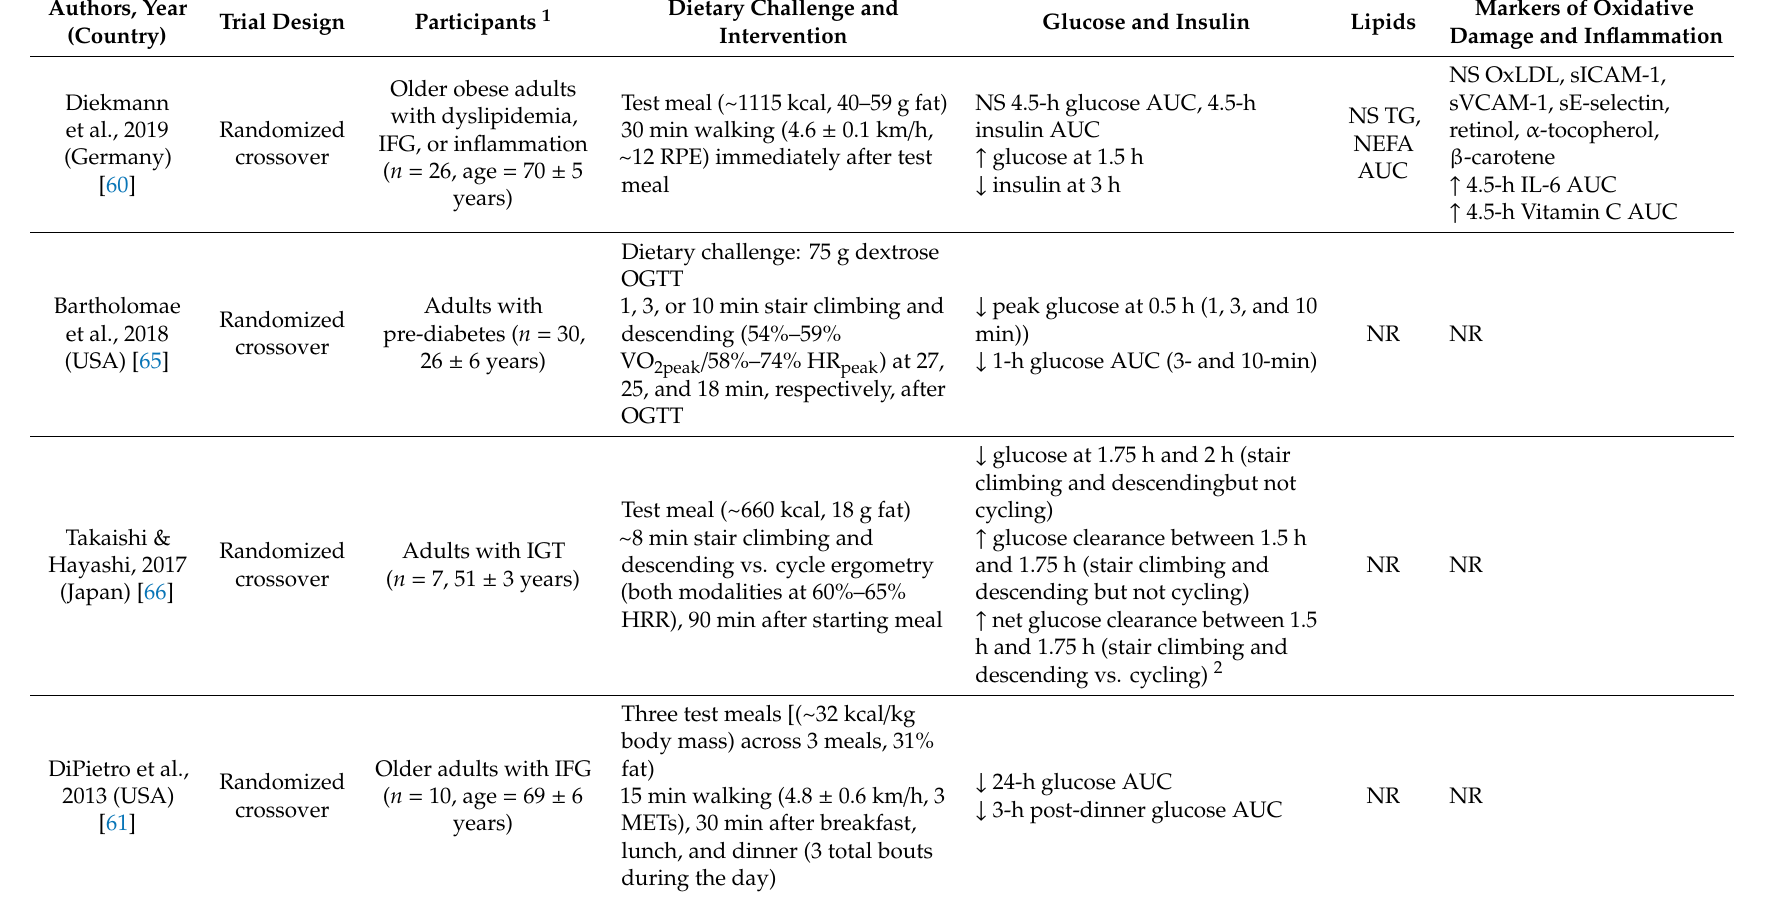
Table 2. Clinical trials on the e ff ects of acute post-meal physical activity on postprandial glucose, insulin, lipids, and markers of oxidative damage and